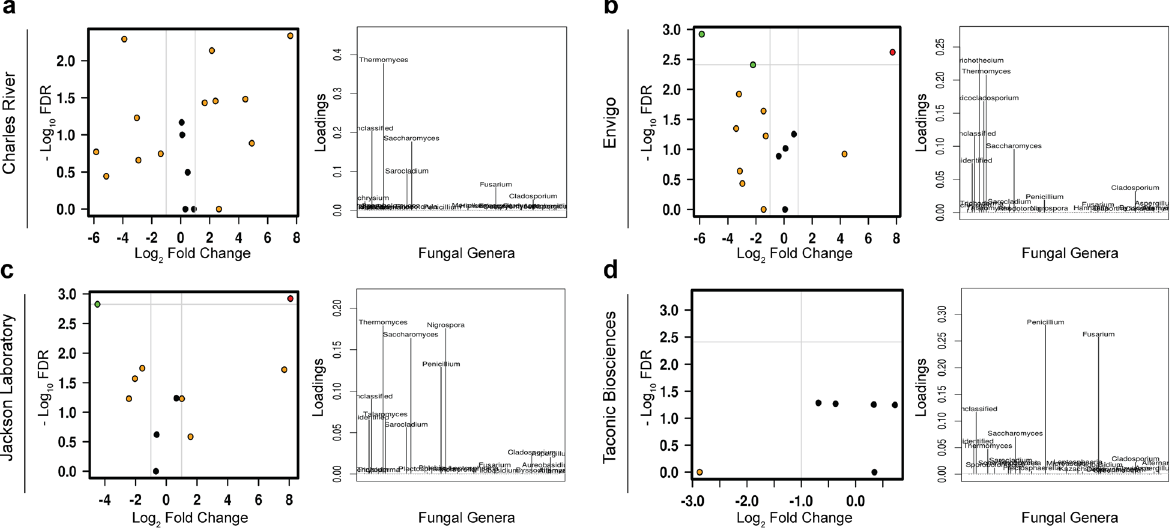
Fig. 4 Differences among animals sourced from different vendors persist after exposure to processed diet. Volcano plots of mixed-effect regression identify differences between animals exposed to a processed diet that are highlighted by loading plots of discriminant analysis of principal components ( a – d ). FDR false discovery